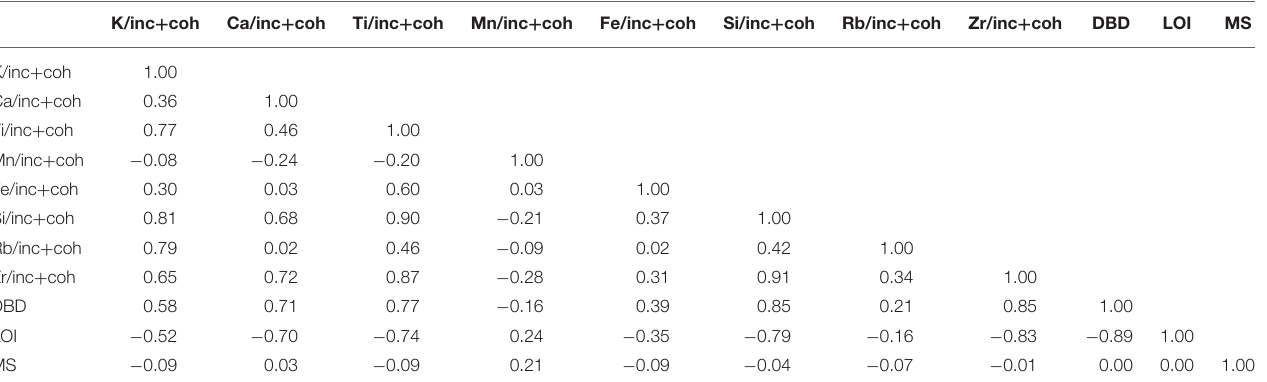
TABLE 3 | Correlation coefficients of selected parameters from